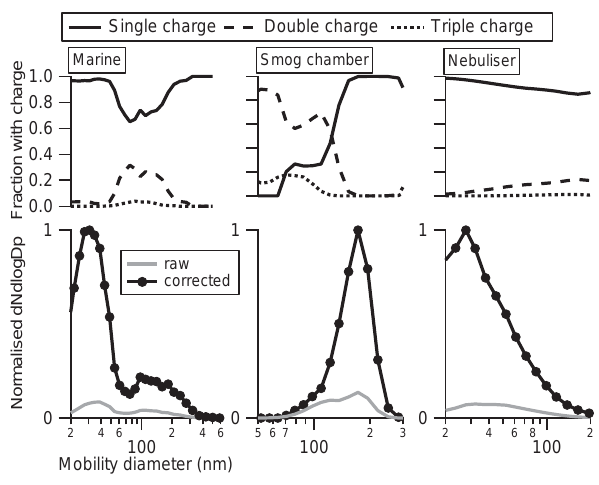
Fig. 1. Example size distributions and the fraction of particles with single, double and triple negative charges at each mobility